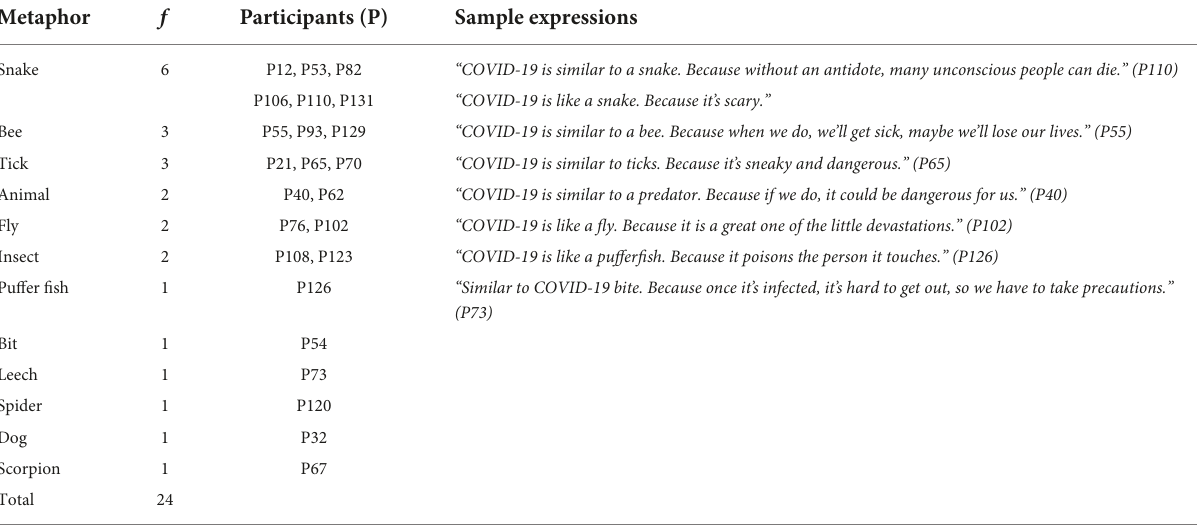
TABLE 5 Animal category.